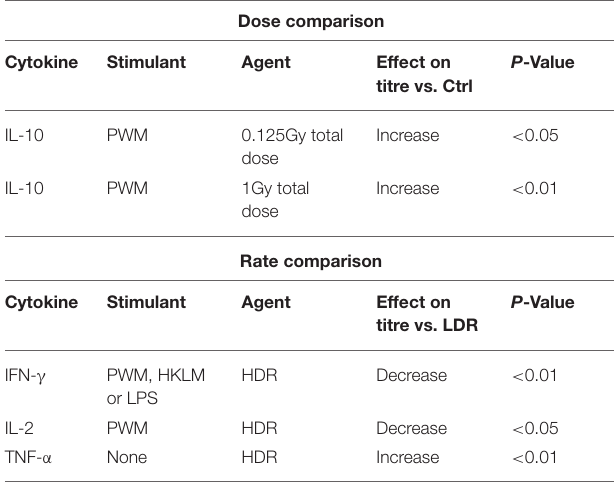
TABLE 1 | Summary of significant observations from pooled dose and dose rate